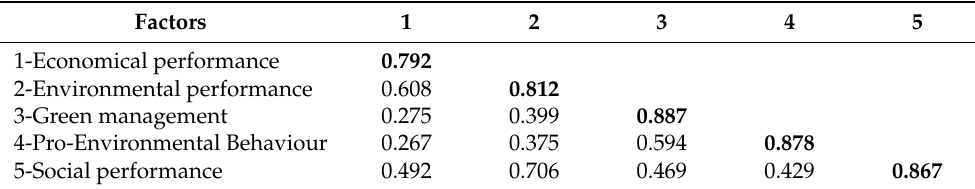
Table 4. Fornell–Larcker criterion matrix.